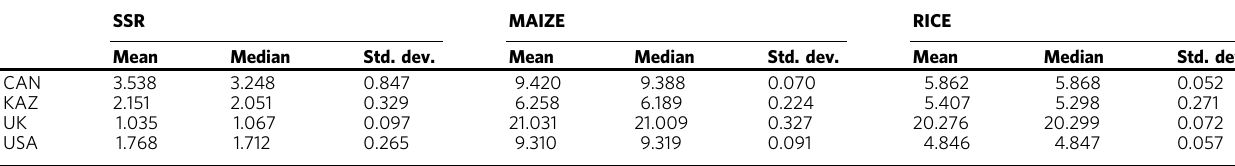
Table 4 Summary statistics for the explanatory variables in the panel analysis.